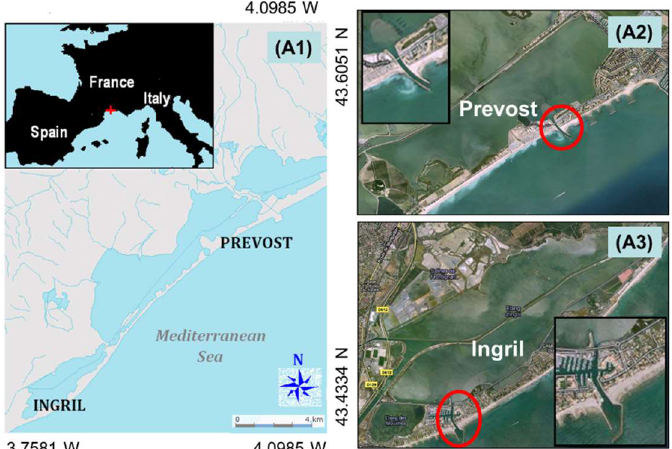
Figure 1. ( A1 ) Map of the study area: the two French Mediterranean shallow water lagoons are located in the same watershed; they are part of a series of shallow ponds, and are both linked to the sea by a single channel. ( A2 , A3 ) On the right, an aerial view of the two lagoons (source: Google earth), with the channels (circle and zoom) where the sonar system was set up.